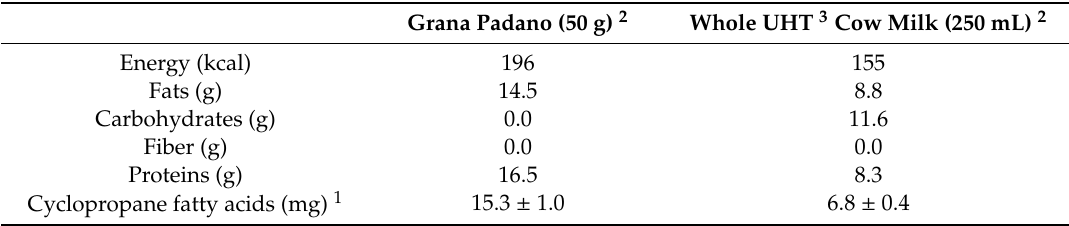
Table 2. Nutritional values and cyclopropane fatty acids (CPFAs) content (mean ± SD) per portion of CPFAs-rich foods supplied to the